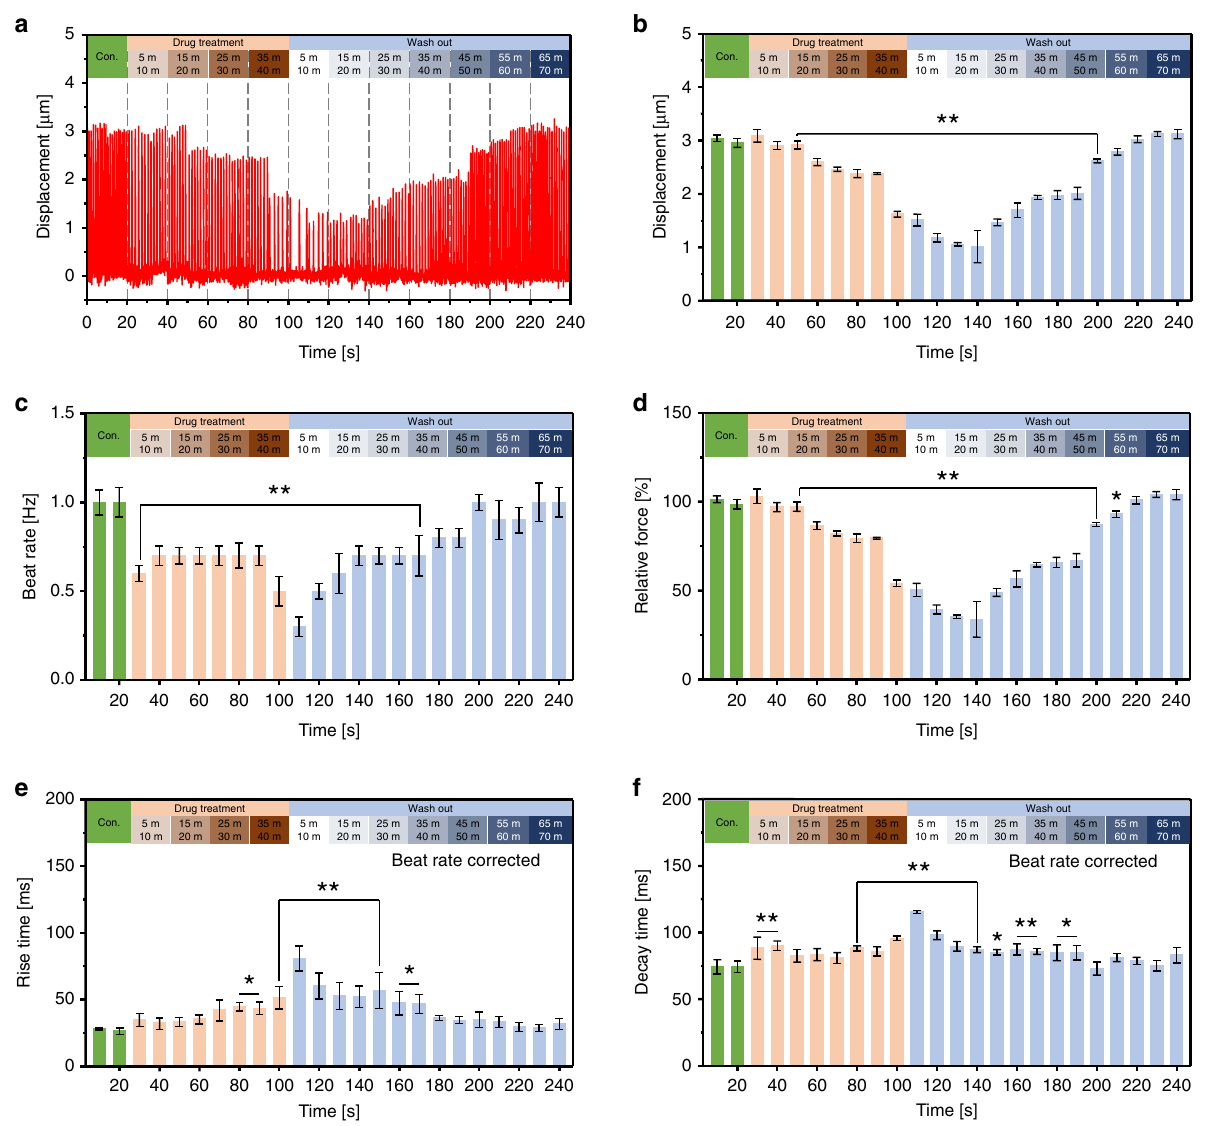
Fig. 8 Real-time traces show the contractility and beat rate of 1 µ M verapamil treated cardiomyocytes. a Displacement of the cantilever owing to the contraction and relaxation of the 1 µ M verapamil treated cardiomyocytes at a different time before and after drug washed out. b , c Displacement of the cantilever after treating the cardiomyocytes with 1 µ M verapamil. d Relative contraction force generated by 1 µ M verapamil treated cardiomyocytes at different drug treatment time. e , f Rise time, and decay time of the 1 µ M verapamil treated cardiomyocytes. The rise time and decay time were analyzed and beat rate corrected with Fridericia ’ s formula (Rise time corrected (Rc) = R/interspike interval 1/3 ) and (Decay time corrected (Dc) = D/interspike interval 1/3 ), respectively. (* p <0.05, ** p <0.01 measures by one-way ANOVA followed by Tukey ’ s honest signi fi cant difference test. Error bars are mean±s.d.). ( n = 5 biologically independent